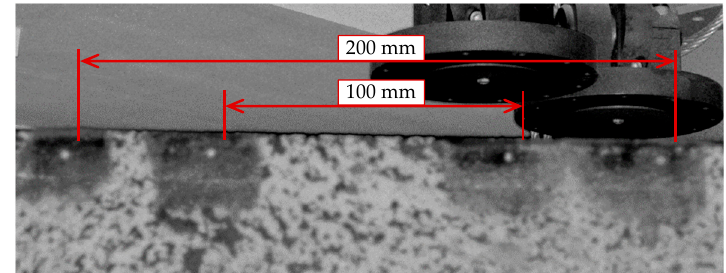
Figure 18. Distribution of points to create an extensometer.